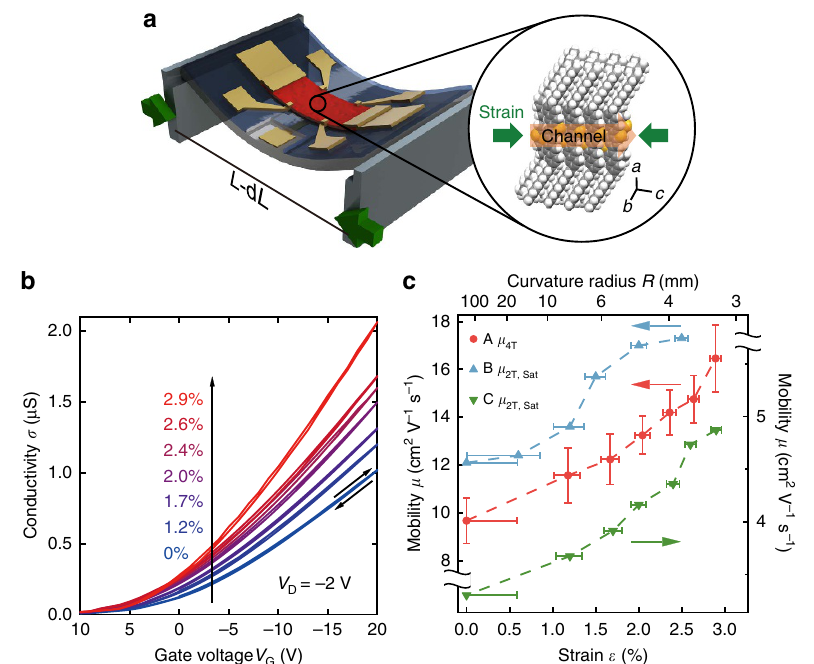
Figure 2 | Evolution of charge transport while bending the substrate. ( a ) Schematics on how uniaxial strain was applied. ( b ) Evolution of the four-terminal conductivity under compressive strain for device A. The inclined arrows show the voltage sweep direction. ( c ) Evolution of the mobility under compressive strain. The average four-terminal mobility during the two compression cycles is shown for device A and the saturation mobility during the first compression for devices B and C. The horizontal error bars indicate the uncertainty of the applied strain deriving from the reading uncertainty of 0.1mm of the compression distance d L when the bending set-up is used, and the vertical error bars for device A represent the s.d. of the mobility during the two compression